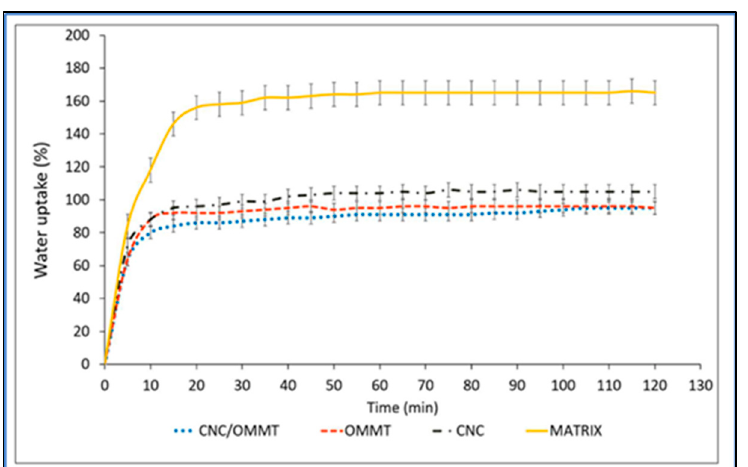
Figure 8. Water uptake of kappa-carrageenan matrix films: κ -carr matrix, κ -carr/CNC bionanocom- posite, κ -carr/OMMT bionanocomposite, and hybrid κ -carr/CNC/OMMT bionanocomposite (Taken from [4], MDPI CC BY).